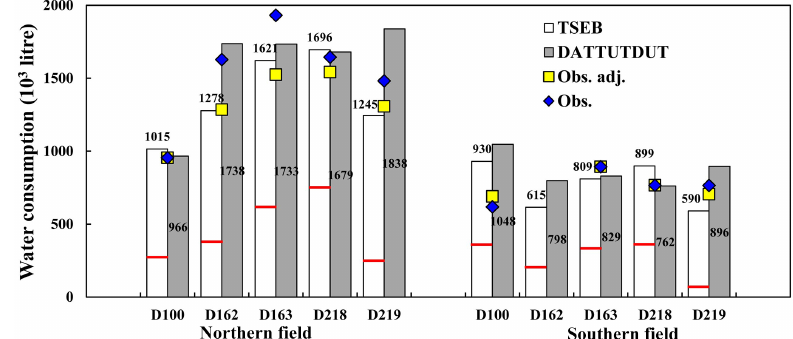
Figure 11. Water consumption calculated from estimates of ET computed by TSEB and DATTUTDUT models for the 5 aircraft overpass days (10 3 L). The numerical values above or in the columns denote the total water consumption from each field as estimated by the two models. For results from TSEB, the red lines separate the total water consumption into soil evaporation below the lines and vegetation transpiration above the lines. The blue diamonds denote the water consumption calculated using the EC tower-based daytime ET observed (obs.) multiplied by the area of the northern and southern vineyards. The yellow squares are the water consumption values from ET obs. adjusted (adj.) by multiplying ET obs. by the ratio of the tower source area LAI and the whole field average